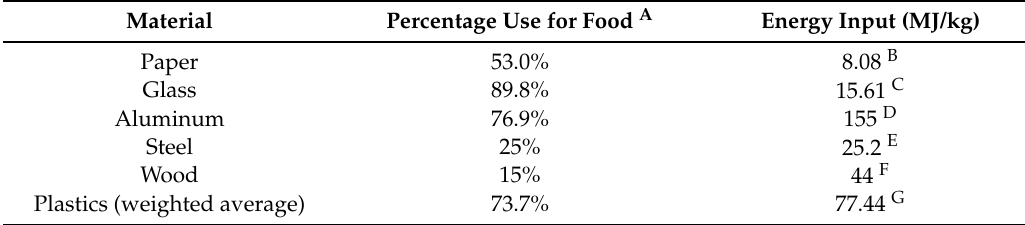
Table A2. Specific input energy for different packaging